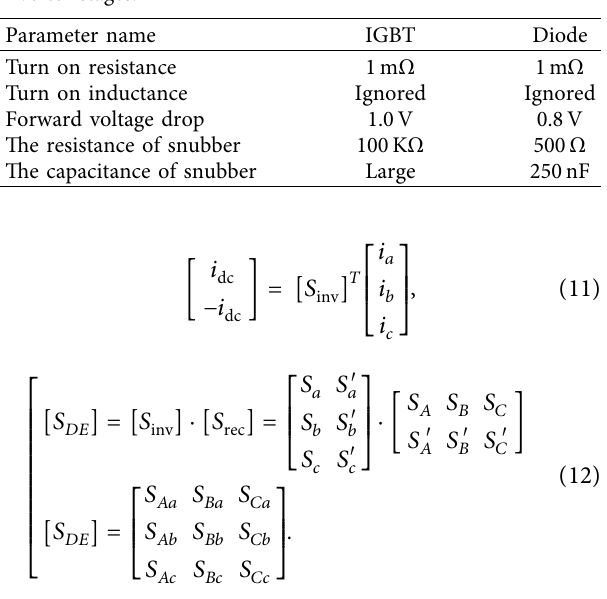
Figure 3: Te power circuit of a three-phase Table 2: Te parameters of IGBT and diode used in rectifer and inverter stages.